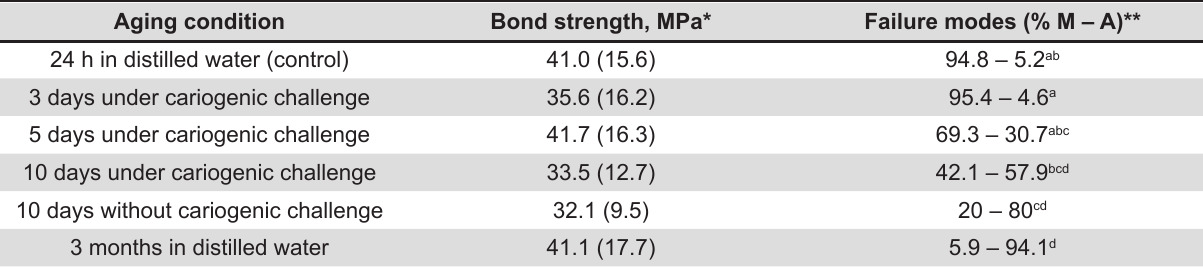
Table 1- Groups tested and results for bond strength and failure